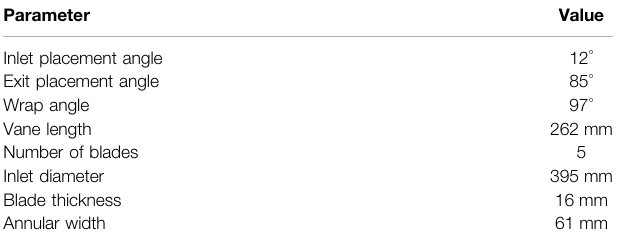
TABLE 3 | Space guide vane parameters.